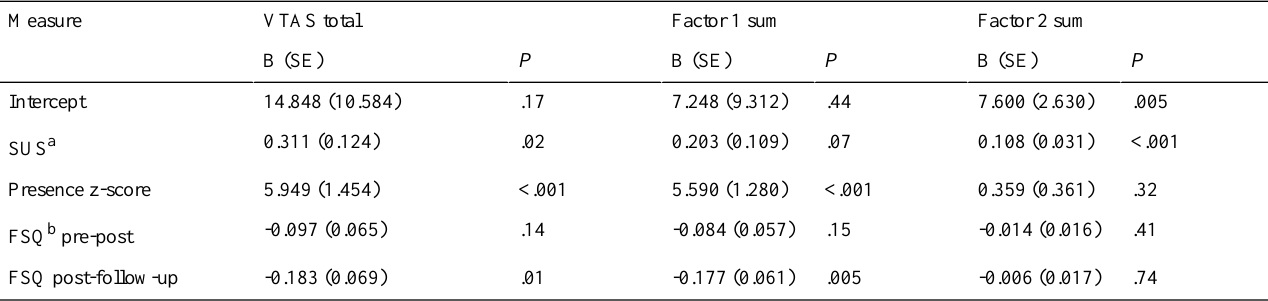
Table 3. Multiple linear regression table of Virtual Therapist Alliance Scale (VTAS) total and factor sum values as dependent variables, with included process measure and outcome difference score